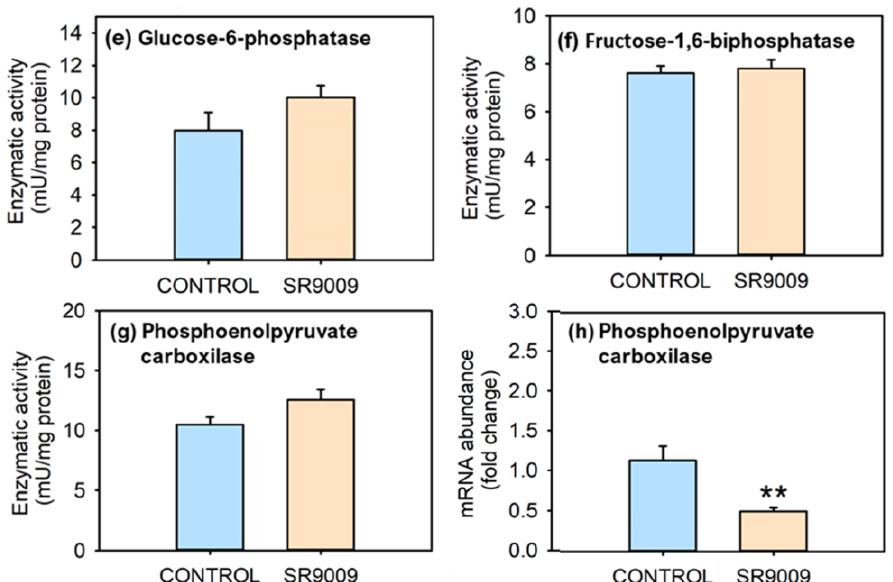
Figure 7. Effect of subchronic SR9009 treatment on enzymes related to glucose metabolism. Activity of enzymes related to glycolysis ( a – d ), glucose anabolism ( e – g ), and pepck mRNA abundance ( h ) in the liver of goldfish ( Carassius auratus ) treated with vehicle alone (CONTROL) or containing SR9009 (100 µ g/g bw). Data are expressed as mean + S.E.M. ( n = 12/group). ** p < 0.01, *** p < 0.001 SR9009 compared to control group (Student’s t -test).